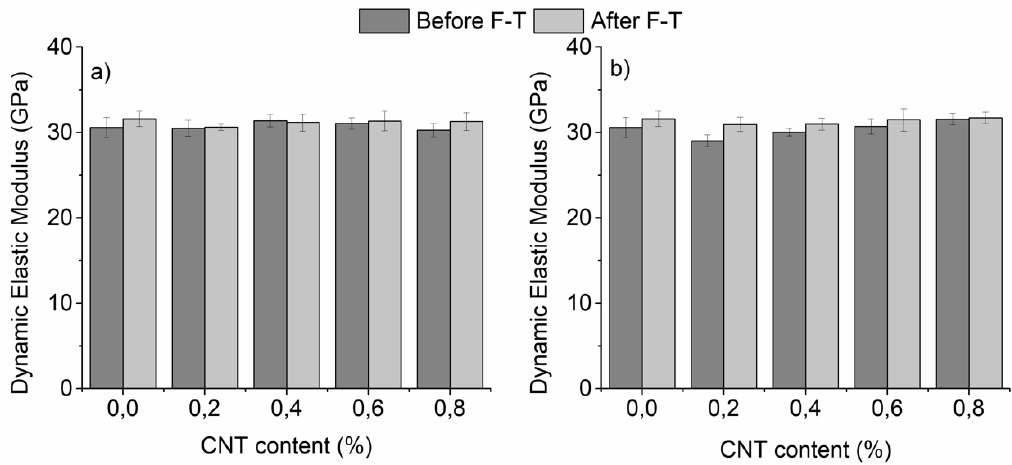
Figure 3. Dynamic elastic modulus of nano-mortars prepared with ( a ) superplasticizer and ( b )